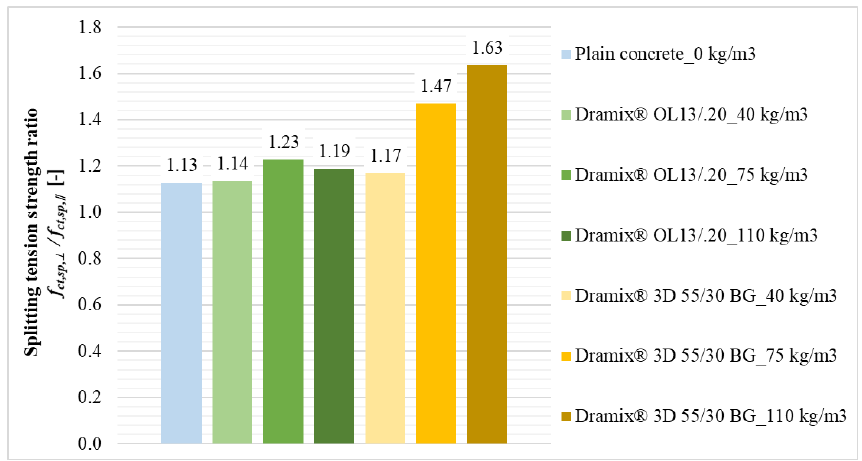
Figure 8. Splitting tensile strength ratio.